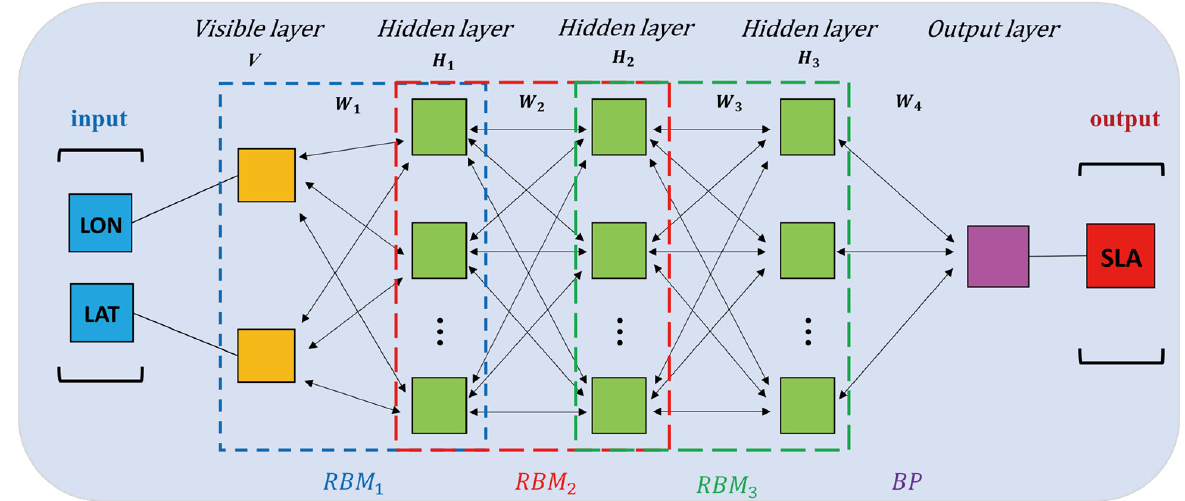
Figure 2. The structure of the SLA estimation model based on DBN method.